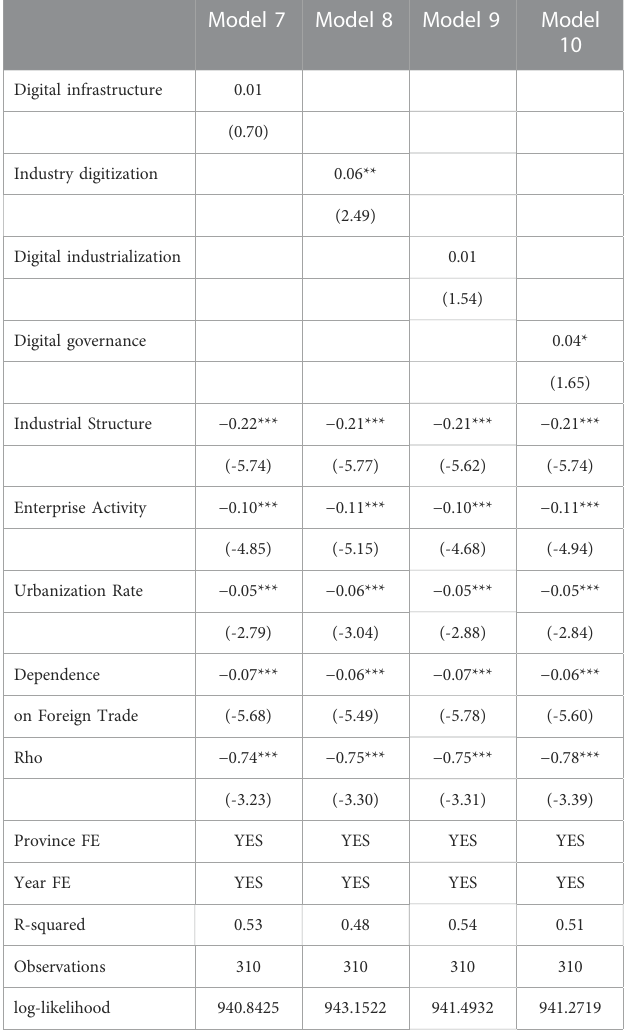
TABLE 9Decompositionof the role ofthe digital economy onrural